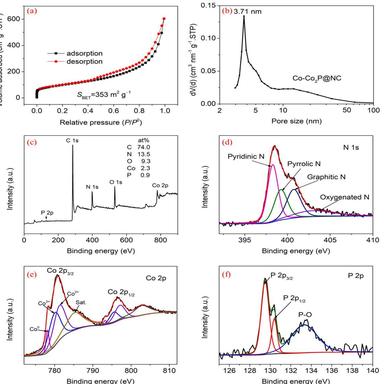
(a) N2 adsorption/desorption isotherms and (b) corresponding pore size distribution curve of Co-Co2P @ NC; (c) XPS survey spectrum and high-resolution XPS (d) N 1 s, (e) Co 2p and (f) P 2p spectra for Co-Co2P @ NC.